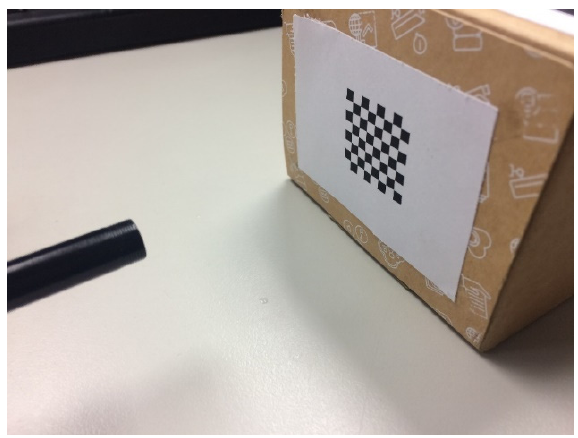
Figure 11. Use of the checkerboard image to correct the camera.